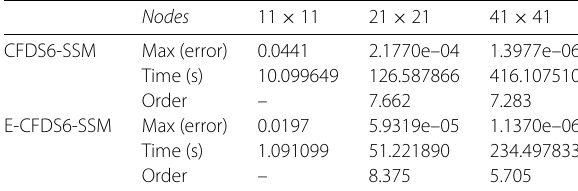
Table 2 The convergence order and computational time for SP 1 at t = 1 Nodes